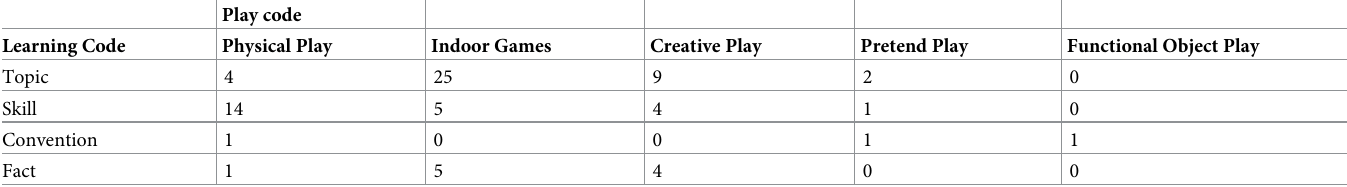
Table 2. Number of children generating at least one example of each type of activity coded as playing and learning (excluding invalid